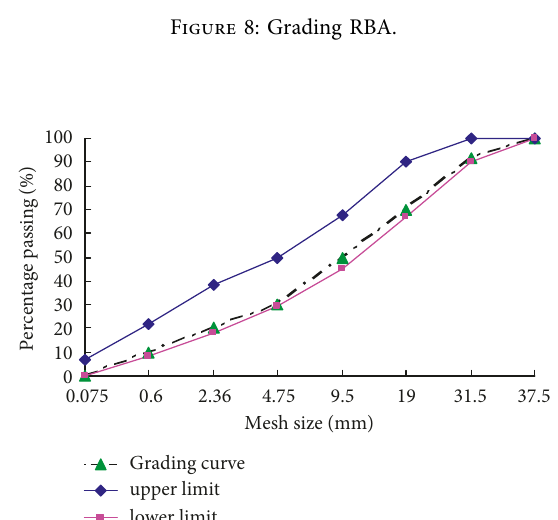
Figure 9: Grading